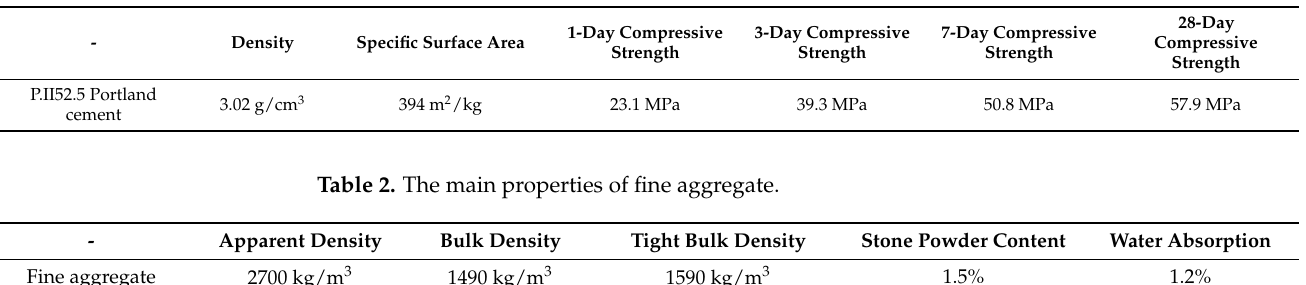
Table 1. The main properties of cement.